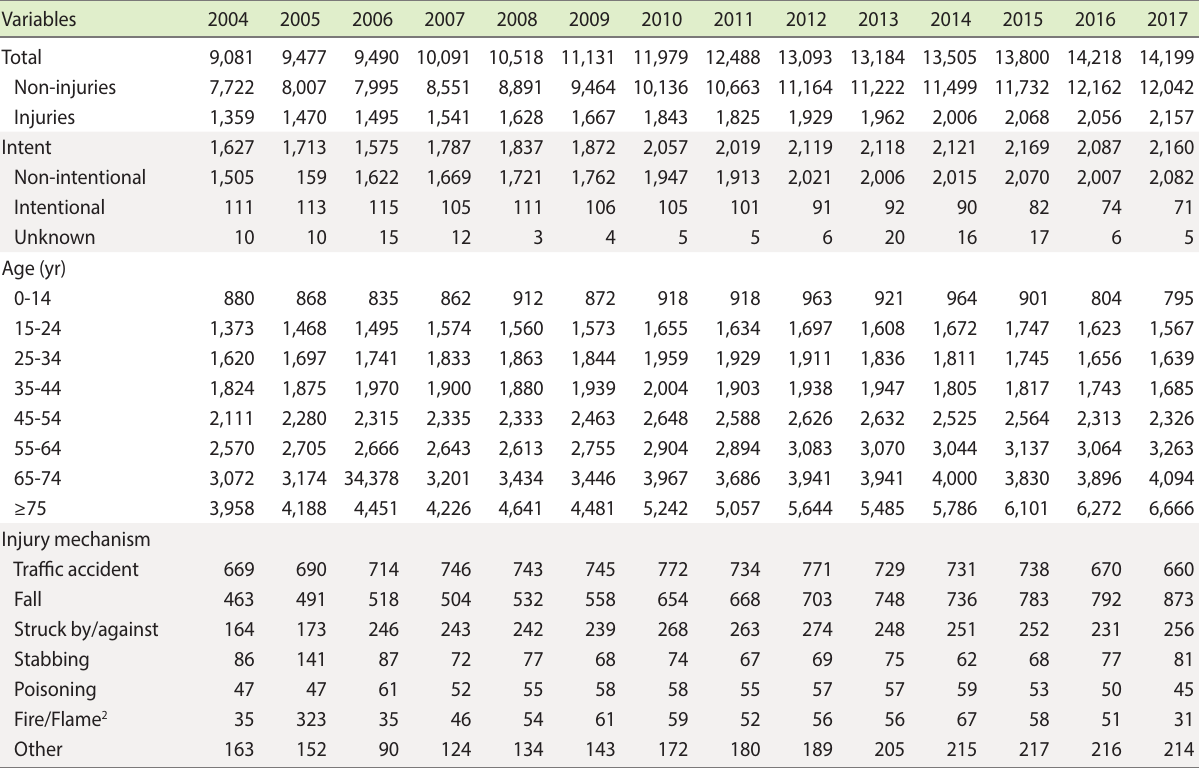
Table 4. Estimated injury discharge rates 1 , 2004-2017